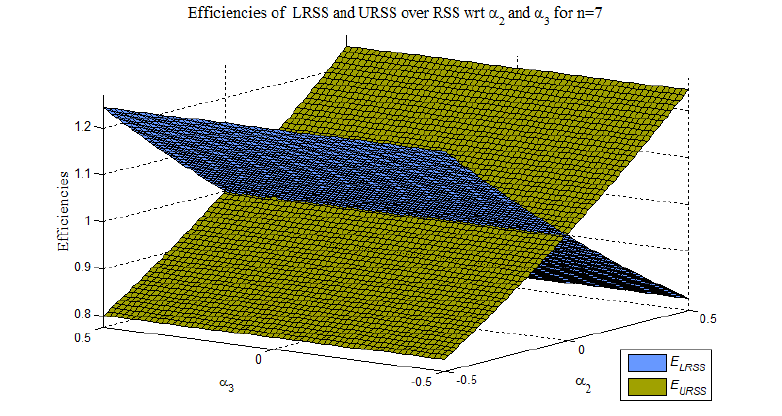
( E ) of ˆ θ ( ˆ θ ) over ˆ θ LRSS URSS 2,LRSS 2,URSS